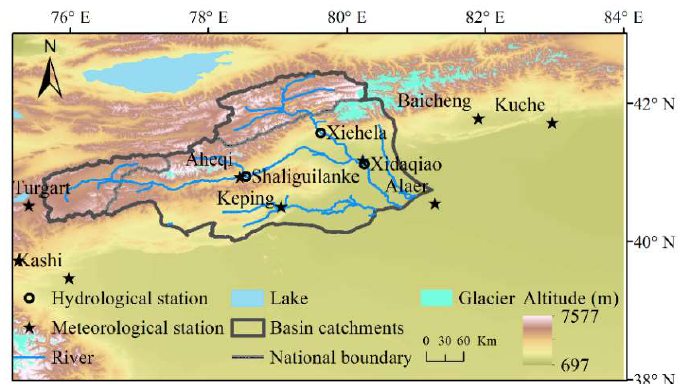
Figure 1. Location of the Aksu River Basin (ARB), northwest China.